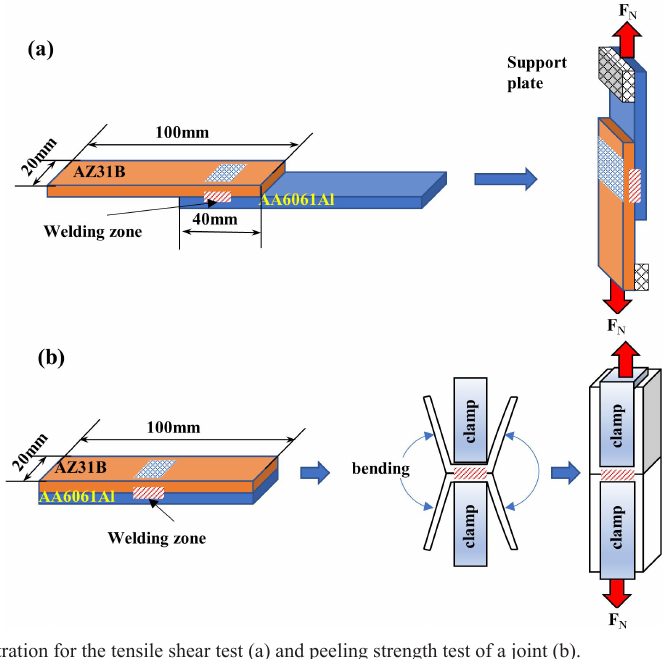
Figure 2. Schematic illustration for the tensile shear test (a) and peeling strength test of a joint (b).